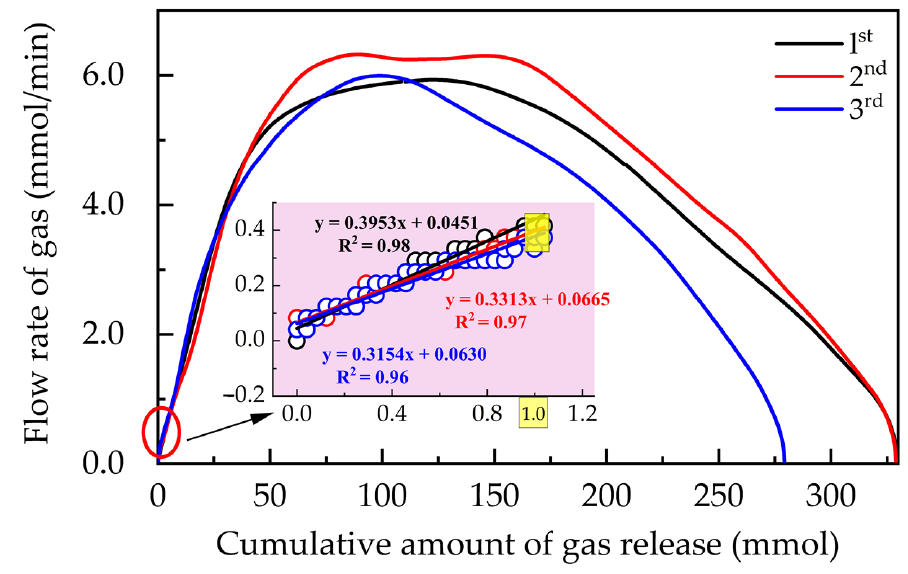
Figure 5. Change in flow rate in addition to the cumulative amount of released gas during the complete dissociation of hydrates formed at 6.5 °C in PW.